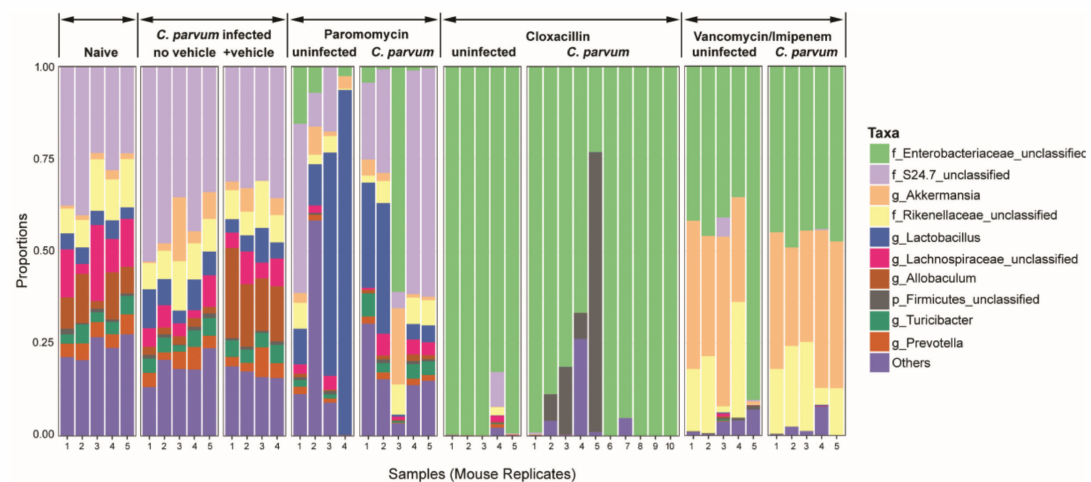
Figure 2. Di ff erences in microbial composition of the microbiota in naïve and C. parvum infected mice including untreated and antibiotic treated groups. Relative abundances of bacterial families are shown and grouped according to their genus; bars represent individual mice within treatment